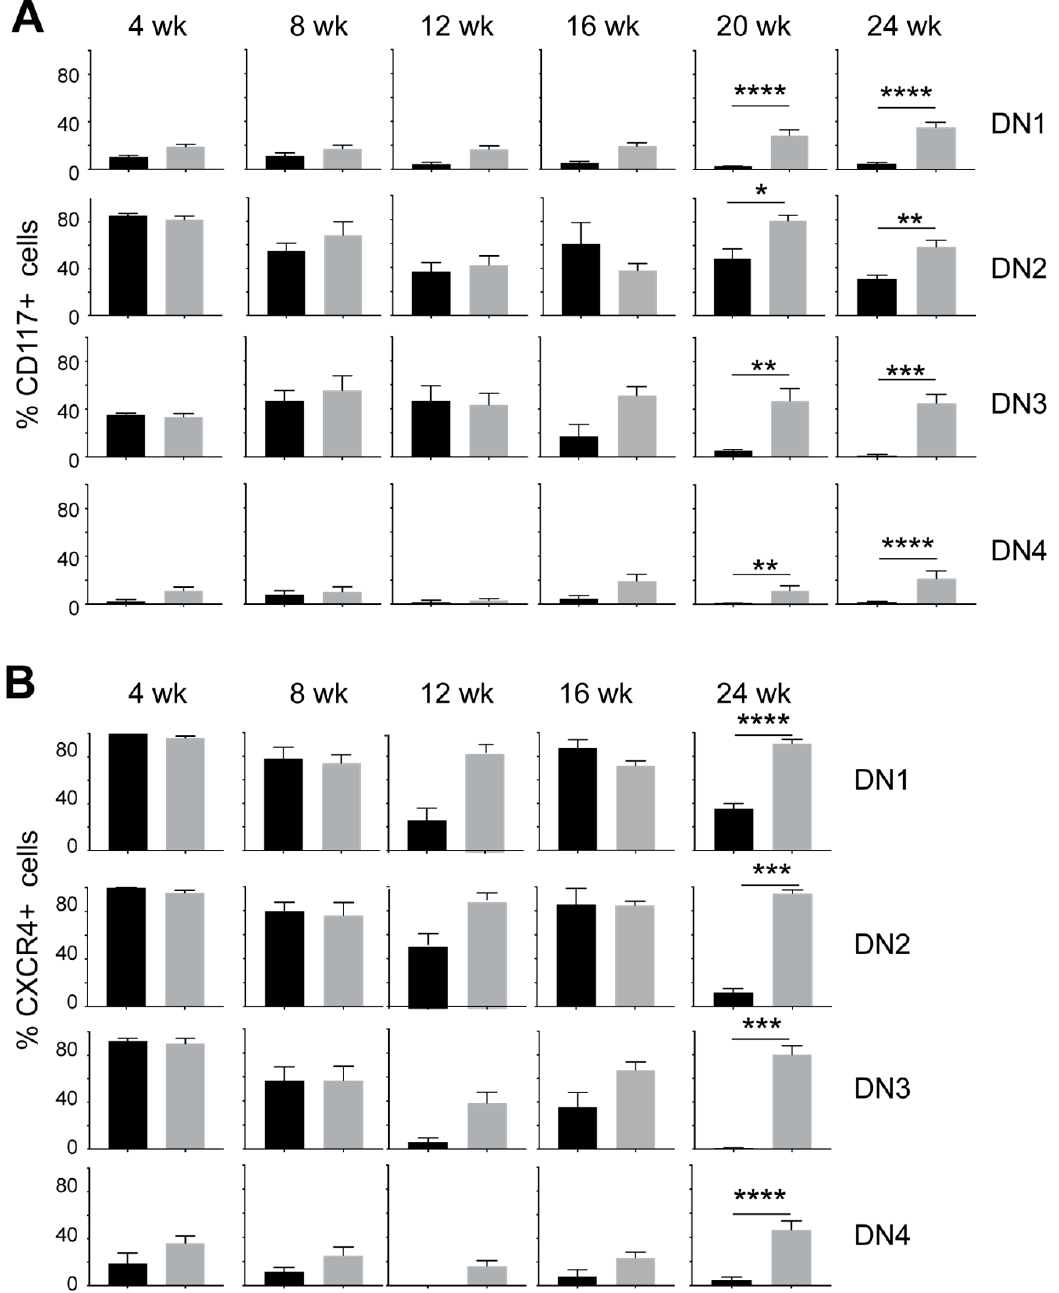
Figure 4. Increased expression of CD117 (cKIT) and CXCR4 in DN thymocyte subsets of IL-15-deficient NOD. Scid mice. Proportion of CD117 + ( A ) and CXCR4 + cells ( B ) in DN1, DN2, DN3 and DN4 subsets in NOD. Scid (black bars) and NOD. Scid.Il15 − / − (gray bars) mice. n = 4–8 mice per group. Mean and standard deviation (SD) are shown. Statistical significance was calculated using Mann–Whitney’s test. * p > 0.05; ** p > 0.01; *** p > 0.001, **** p > 0.0001.